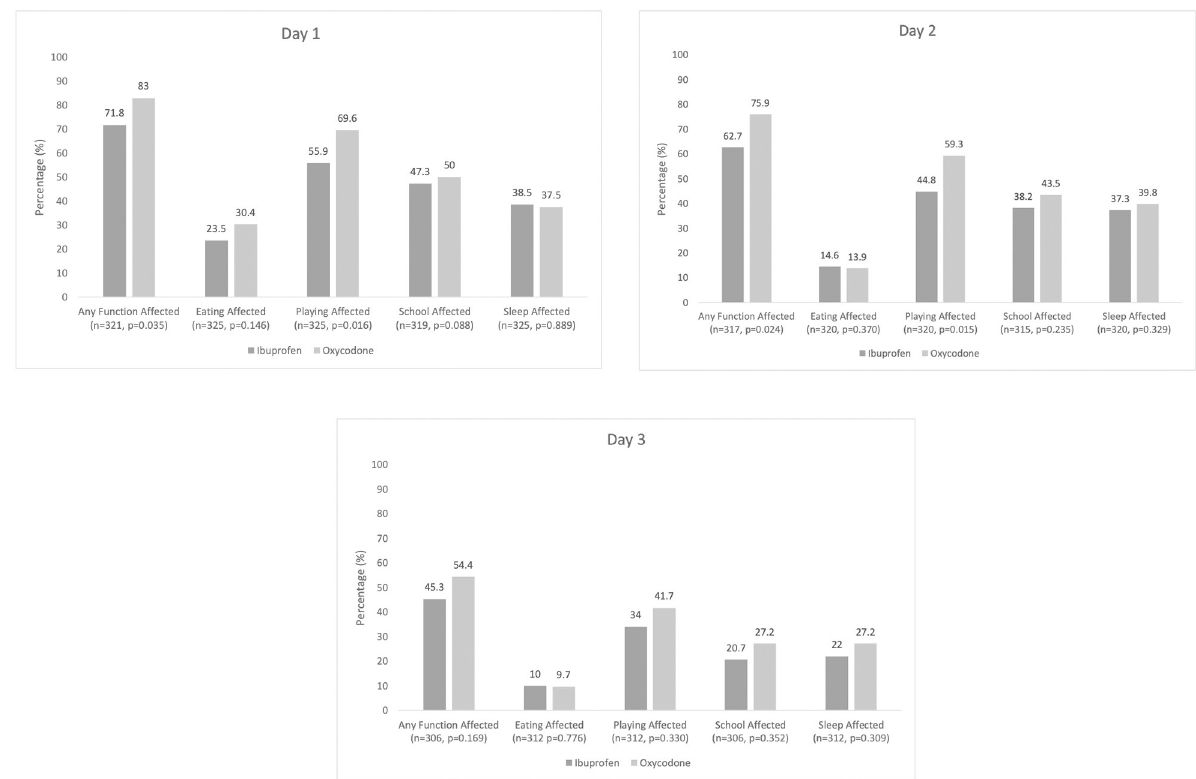
Fig 2. A. Functional outcomes by group (Day 1). B. Functional outcomes by group (Day 2). C. Functional outcomes by group (Day 3).